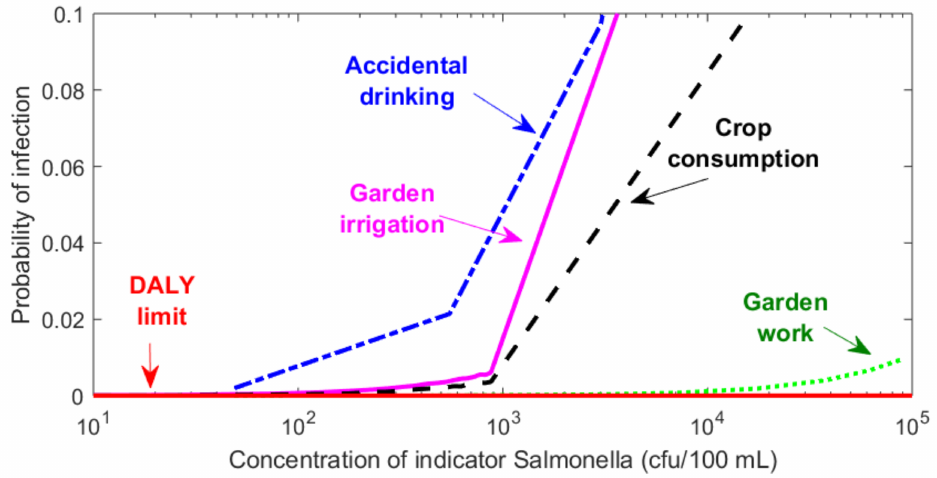
Figure 1. Probability of infection from Salmonella enterica in greywater under four worst-case exposure scenarios. The red solid horizontal line represents the DALY limit of acceptable risk as suggested by the WHO [25].